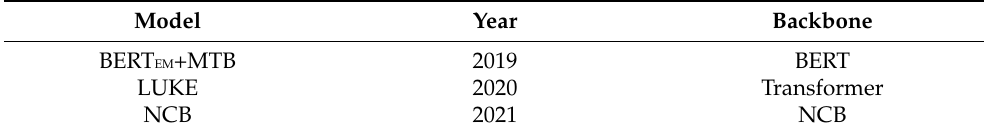
Table 4. Information of RE